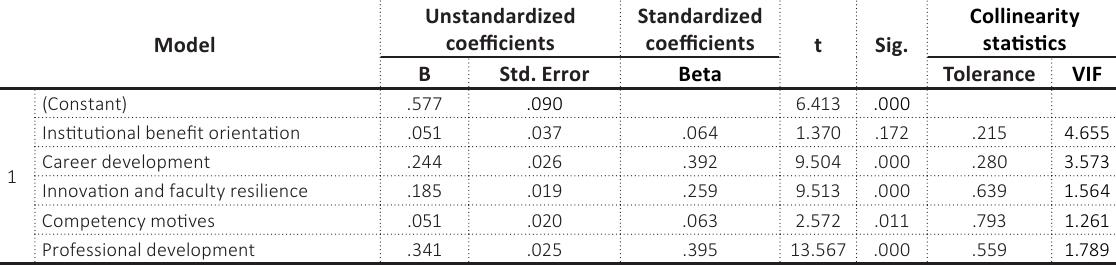
Table 6. Impact of faculty development program on faculty performance: Direct effect